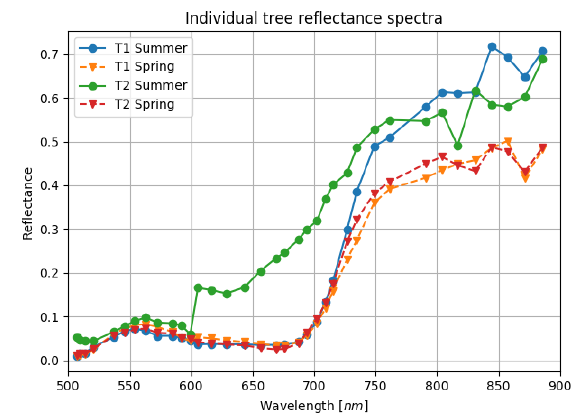
Figure 6. Reflectance spectra of individual trees, 3x3 pixel